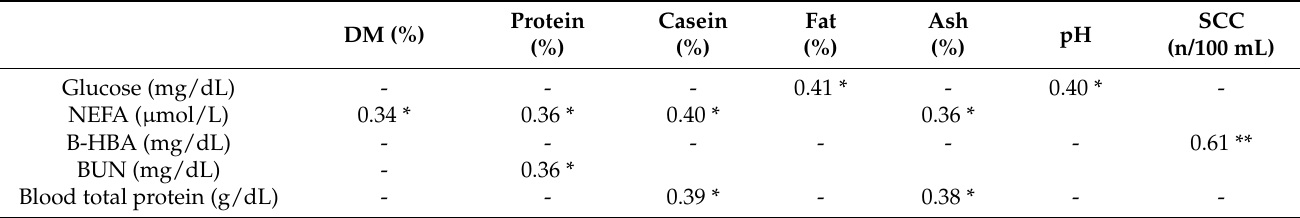
Table 5. Correlations between blood metabolic parameters and milk quality (only the statistically significant correlations are